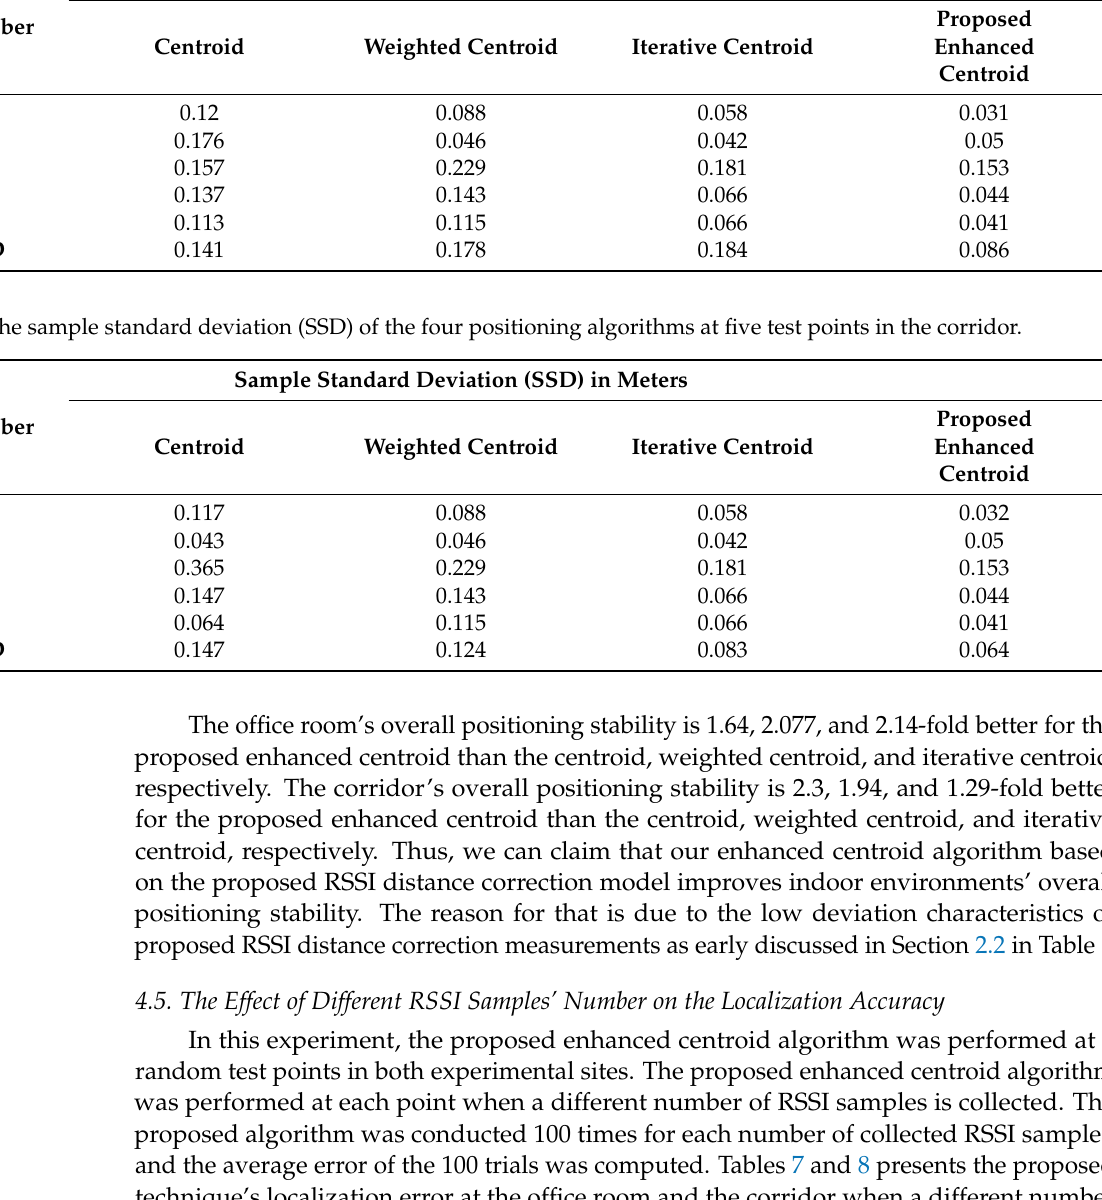
Test Point Number